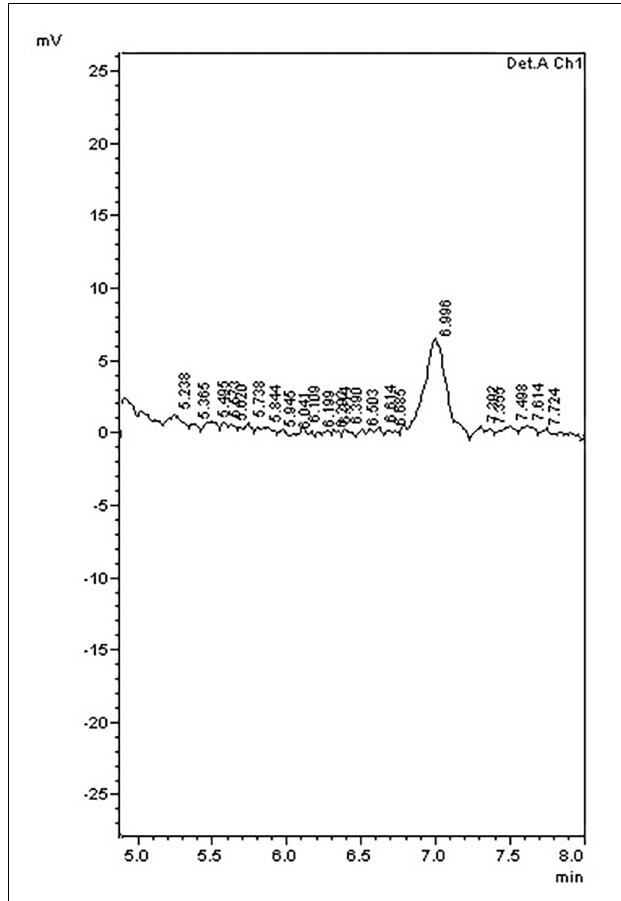
FIGURE 8 | HPLC phytic acid peaks of seed extracts from transgenic line P6-39-10.